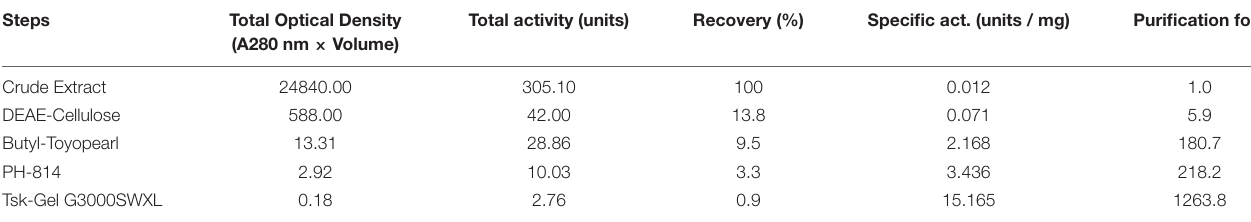
TABLE 1 | Purification of Endo- β -GlcNAc-ase from rice culture